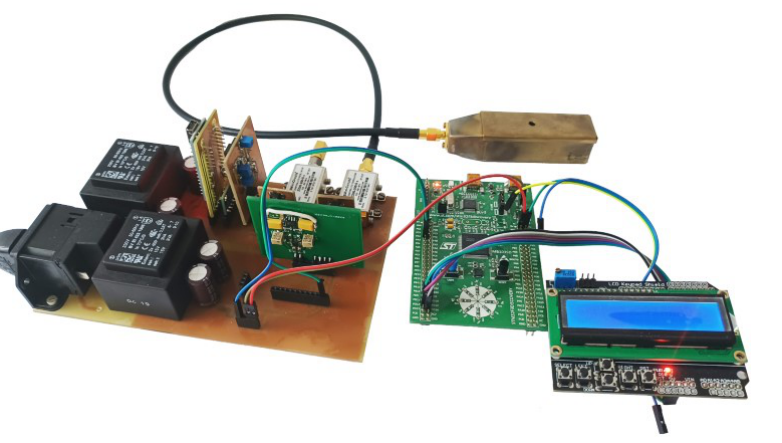
Figure 15. Assembled measurement setup as explained in Figure